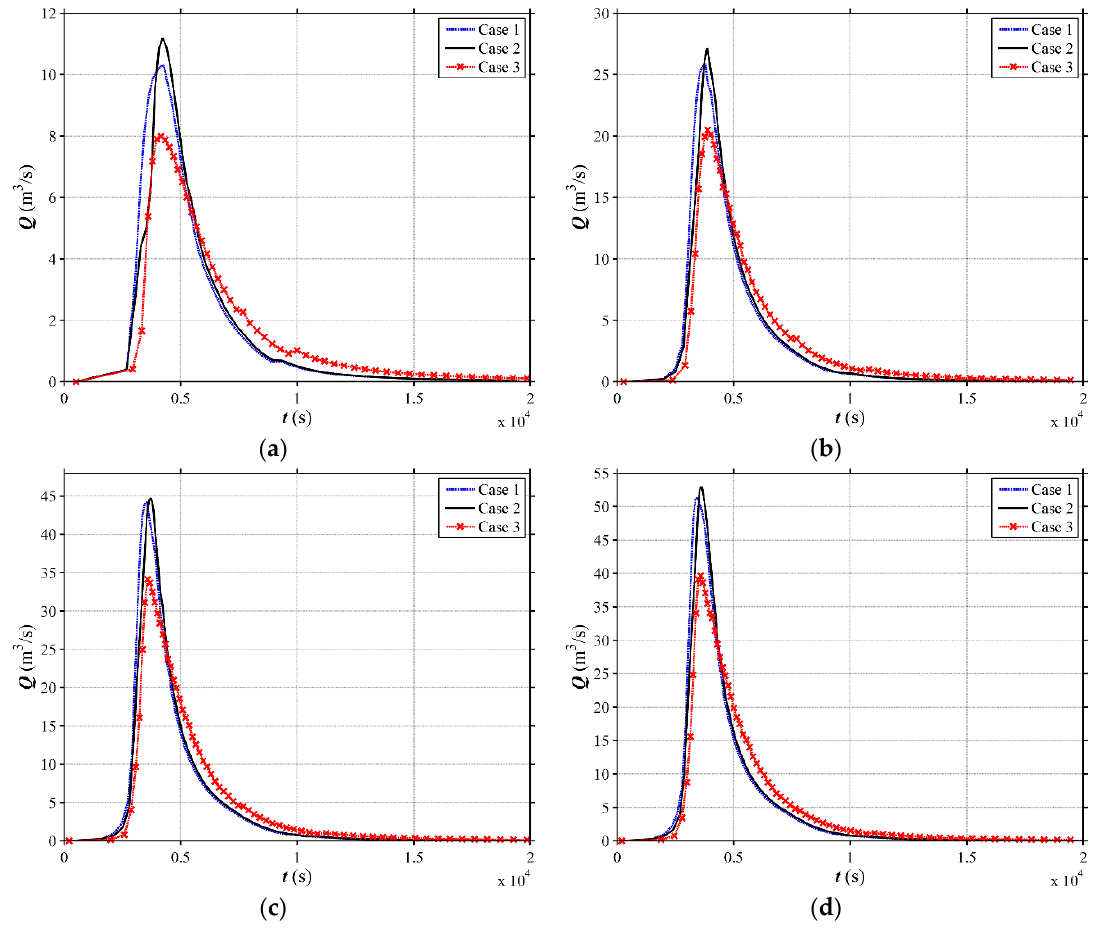
Figure 8. Simulated hydrographs at the outlet for different land use scenarios in the V-shaped catchment with i 1 = 0.08. ( a ) 2-year; ( b ) 10-year; ( c ) 50-year; ( d ) 100-year.